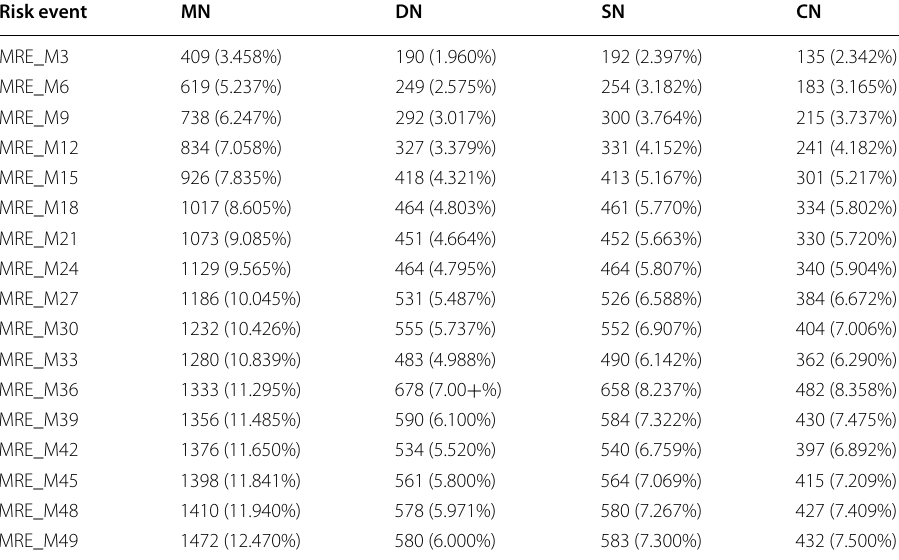
AP in different networks +